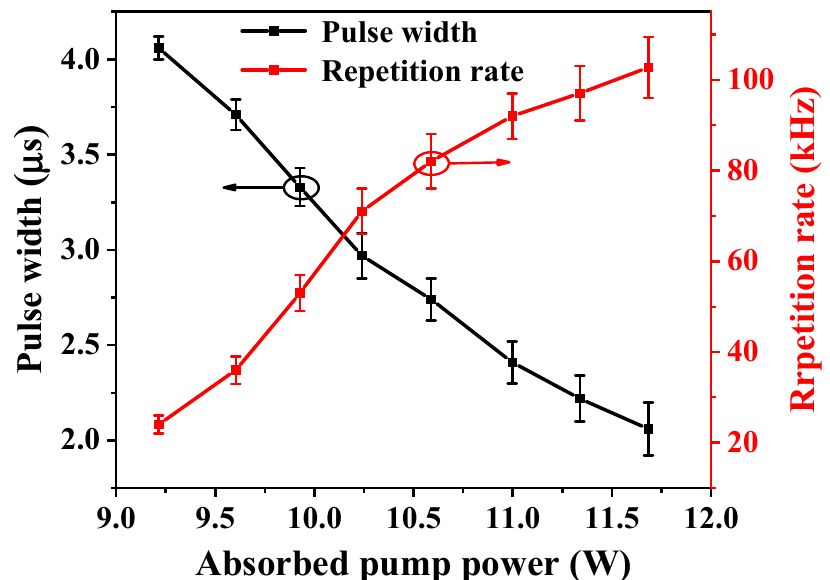
Figure 3. Pulse width and PRF vs. the absorbed pump power. Figure 4 shows the relationship between the single pulse energy and peak power vs. the absorption pump power. When the absorbed pump power was at its maximum, 11.7 W, the single pulse energy was also at its maximum of 6.2 µ J, corresponding to the peak power of 3 W.